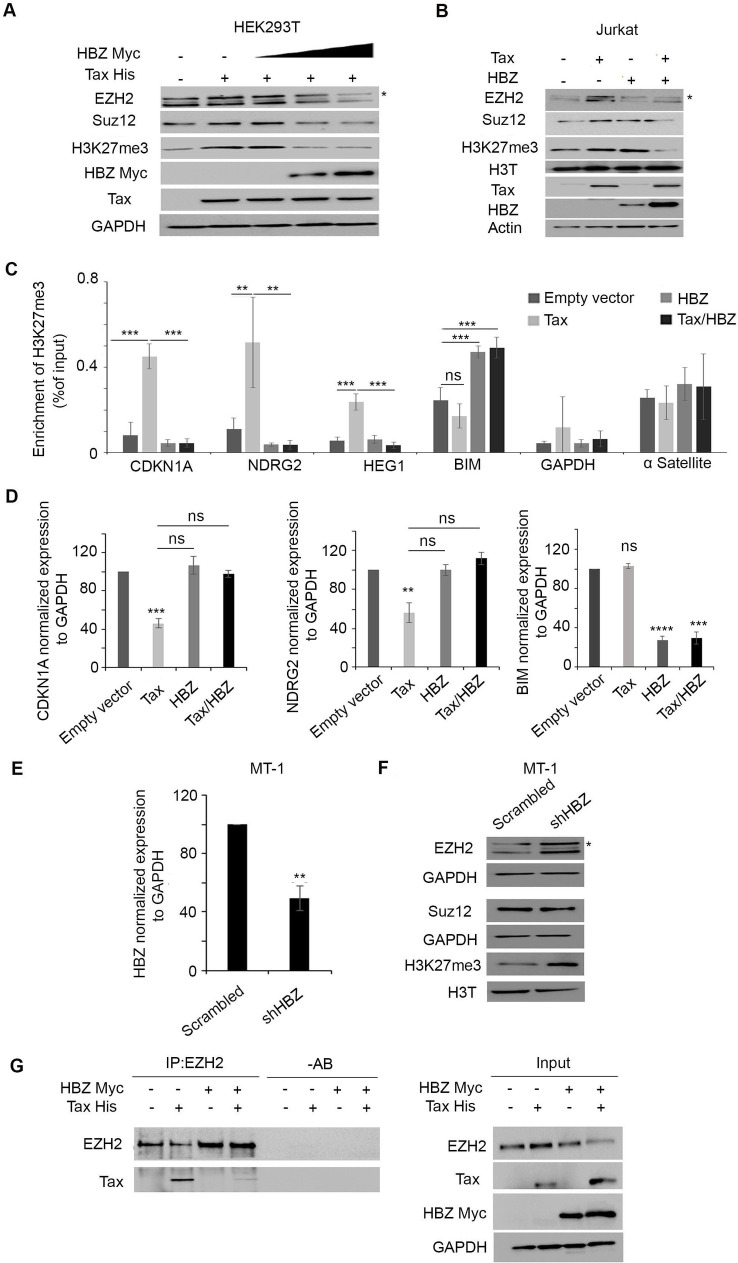
HBZ overexpression prevents Tax-induced PRC2 activation in human cells.(A) HEK293T cells were transiently co-transfected with His-Tax and increasing amount Myc-HBZ. Western blot was performed with indicated antibodies. Asterisk denotes to the band corresponding to EZH2. (B) Jurkat cells were transiently co-transfected with an empty vector (control), Tax, HBZ, or Tax and HBZ expression plasmids. Western blot was performed with indicated antibodies. Asterisk denotes to the band. (C) Chromatin immunoprecipitation (ChIP)-qPCR analyses were performed on HEK293T cells co-transfected with either an empty vector or HIS-Tax alone or together with Myc-HBZ. 48 hours post-transfection, genomic DNA was fixed with 1% formaldehyde and sheared using Bioruptor. Sheared chromatin was diluted and immunoprecipitated using anti-H3k27me3 antibody. GAPDH was used as a negative control and α-satellite as a positive control. The immunoprecipitated material was quantified by qPCR. Results were normalized to inputs and expressed as %DNA input. (ns = not significant), p<0.001 (***) and p<0.01 (**). (D) Transcript levels of CDKN1A, NDRG2 and BIM. Reported values are the average of three independent experiments, and the error bars represent SD of the triplicates. (ns = not significant), p<0.01 (**).), p<0.001 (***), p<0.0001 (****). (E) MT-1 cells were transduced with non-targeting control shRNA (sh scrambled) or shRNA against HBZ (shHBZ). qRT-PCR of HBZ confirming HBZ knockdown in MT-1 cells. Reported values are the average of three independent experiments, and the error bars represent SD of the triplicates. p<0.01 (**). (F) Western blot analysis was performed with indicated antibodies in MT-1 cells transduced with shHBZ or sh Scrambled. Asterisk denotes to the band corresponding to EZH2. (G) HEK293T cells transiently transfected with an empty vector (control), Tax, HBZ, or Tax and HBZ expression plasmids. EZH2 immunoprecipitates (IP: EZH2) were blotted against EZH2 and Tax (Left panel).–AB represents a control with no antibody. Corresponding control cell lysates are shown as indicated (Right panel).